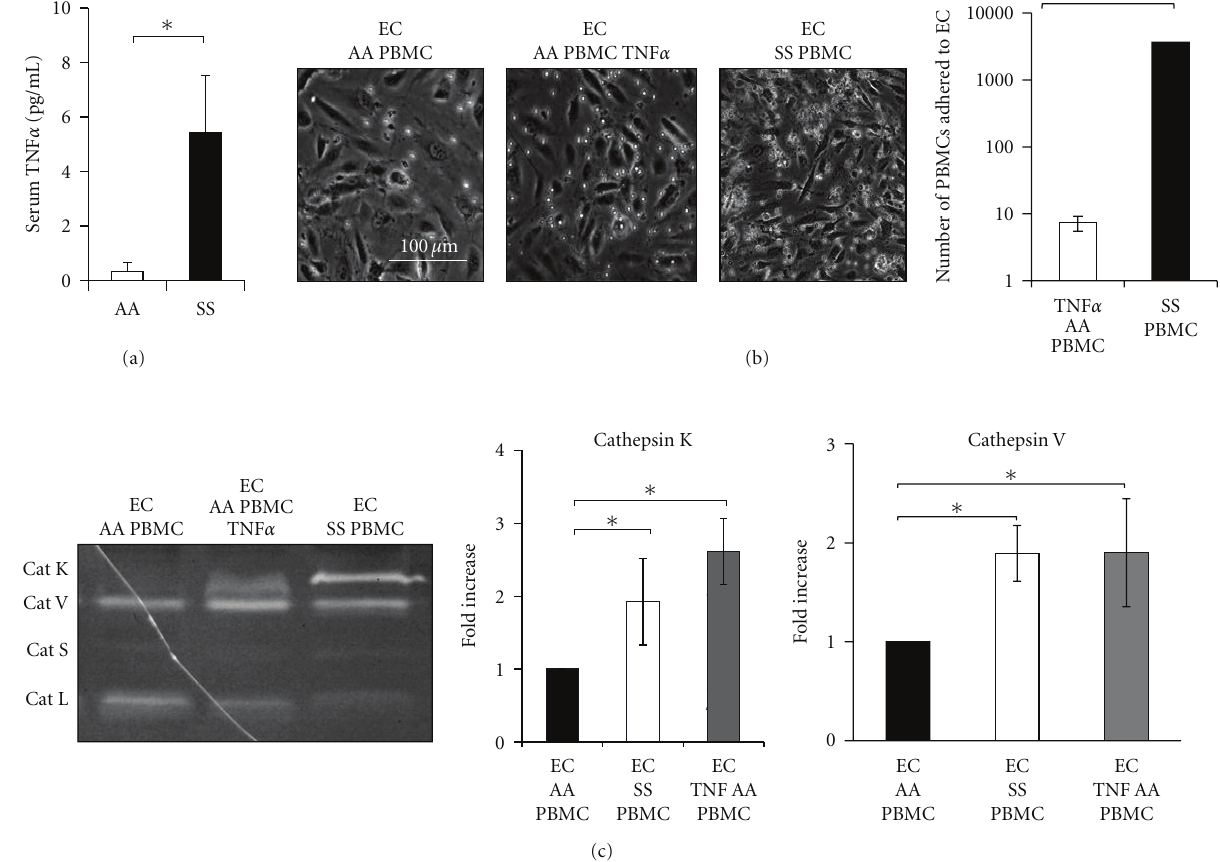
Figure 1: Sickle cell disease preconditions circulating peripheral blood mononuclear cells to induce cathepsin K activity. Whole blood samples were obtained from donors homozygous for the normal β -globin allele (AA) and homozygous for the sickle allele (SS). (a) Baseline serum levels of TNF α were quantified using an ELISA specific for human TNF α ( n = 3, ∗ P < 0 . 05, SEM bars shown). (b) PBMCs were isolated via di ff erential centrifugation through a density gradient. For cocultures, confluent EC cultures were preconditioned with 10 ng/mL TNF α for 4 hours, prior to the addition of either AA or SS PBMCs. Nonadherent cells were washed away, and cocultures were maintained for an additional 20 hours. Representative images of cocultures were used for mononuclear cell adhesion counts. (c) Cells were lysed and cathepsin K activity was assessed using multiplex cathepsin zymography and quantified via densitometry ( n = 10, ∗ P < 0 .